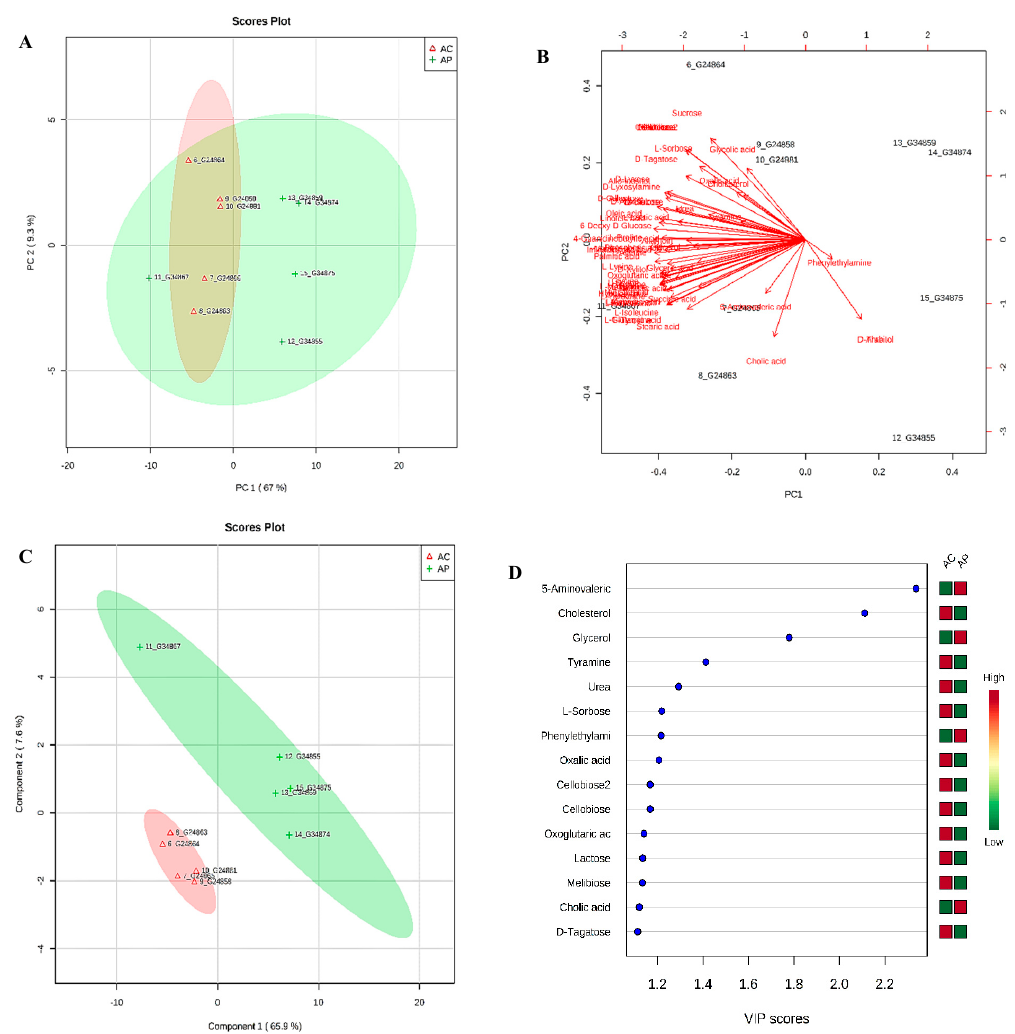
Figure 6. ( A ) PCA plot of feces collected from aging control (AC, red color) and aging probiotic groups (AP, green color) showing divergence. ( B ) Bi-plot showing compounds responsible for divergence ( C ) 2D-PLS-DA plot showing spatial division among groups ( D ) Key compounds separating AC and AP based on variable importance in projection (VIP) score plot in PLS-DA analysis.